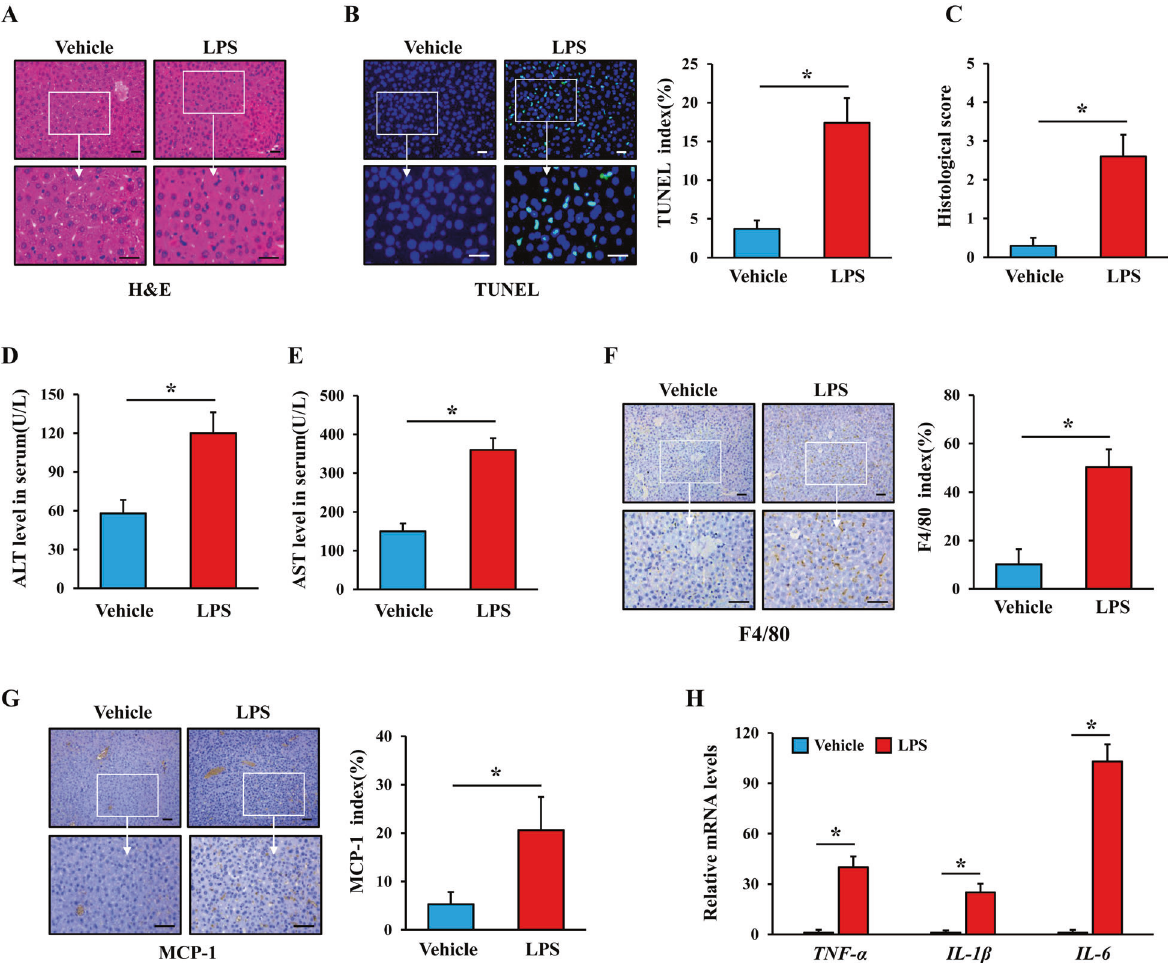
Fig. 1 LPS induced acute liver injury and hepatic macrophage in fi ltration. Mice were intraperitoneally administered either physiological saline (vehicle) or a single LPS injection (5 mg/kg), and the mouse livers were harvested at 6 h. A Representative H&E staining of livers in vehicle- and LPS-induced WT mice (scale bar: 25 μ m). B TUNEL staining of livers in vehicle- and LPS-induced mice (scale bar: 25 μ m), and the positive TUNEL index was scored. C Liver histology scoring in vehicle- and LPS-induced mice. D , E Serum ALT and AST levels in vehicle- and LPS-induced mice. F , G F4/80 and MCP-1 staining of livers in vehicle- and LPS-induced mice (scale bar: 50 μ m), and the positive F4/80 and MCP-1 indexes were scored. H TNF- α , IL-1 β , and IL-6 mRNA levels in vehicle- and LPS-induced WT mouse liver tissues were analyzed by real- time PCR. All values are the mean ± SD ( n = 6 in each group). * P < 0.05 by Student ’ s t